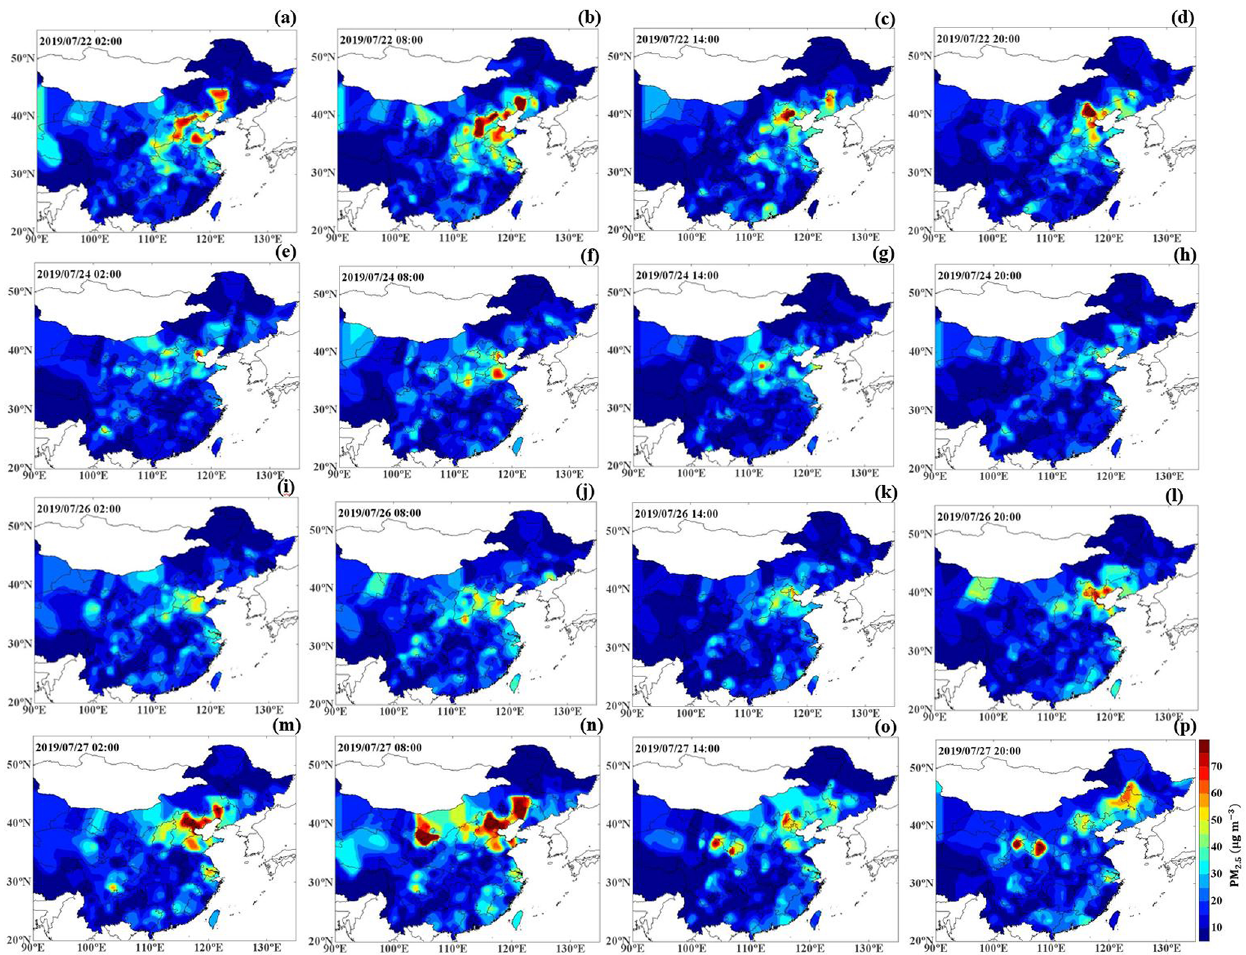
Figure 8. The PM 2 . 5 mass concentration distribution (units: µgm − 3 ; shaded colors) over most of China at 02:00, 08:00, 14:00 and 20:00LT on 22, 24 and 26–27 July, labeled as (a–p)